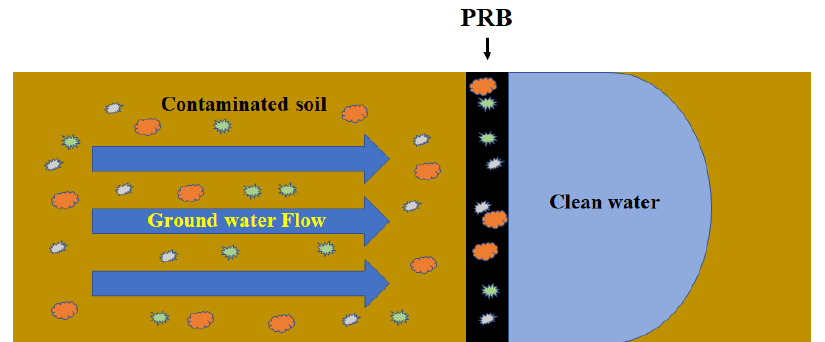
Figure 3. Permeable reactive barrier (PRB).